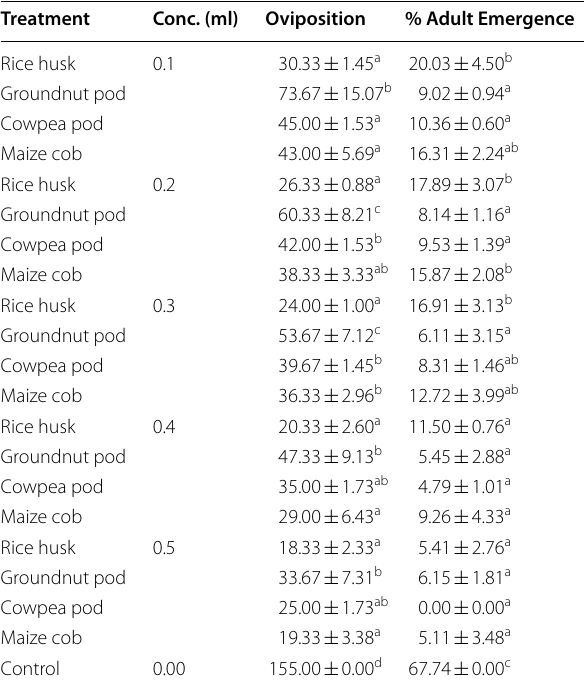
Table 8 Effect of agro waste extracts on oviposition and adult emergence of C. maculatus